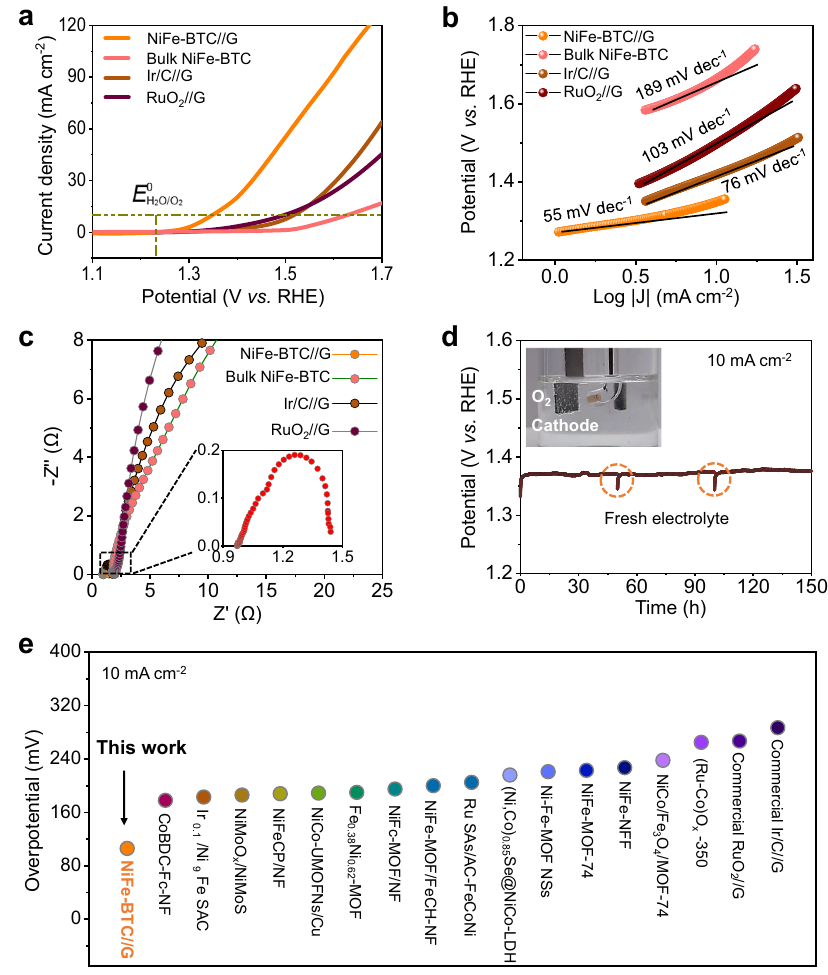
Fig. 2 | OER electrochemical activity of NiFe-BTC//G. a LSV plots obtained with NiFe-BTC//G,bulkNiFe-BTC,commercialIr/CandRuO 2 forOERat10mVs − 1 in1.0M KOHwithAg/AgClasreferenceelectrode. b TafelplotsobtainedwithNiFe-BTC//G, bulk NiFe-BTC, commercial IrO 2 and RuO 2 . c EIS Nyquist plots.